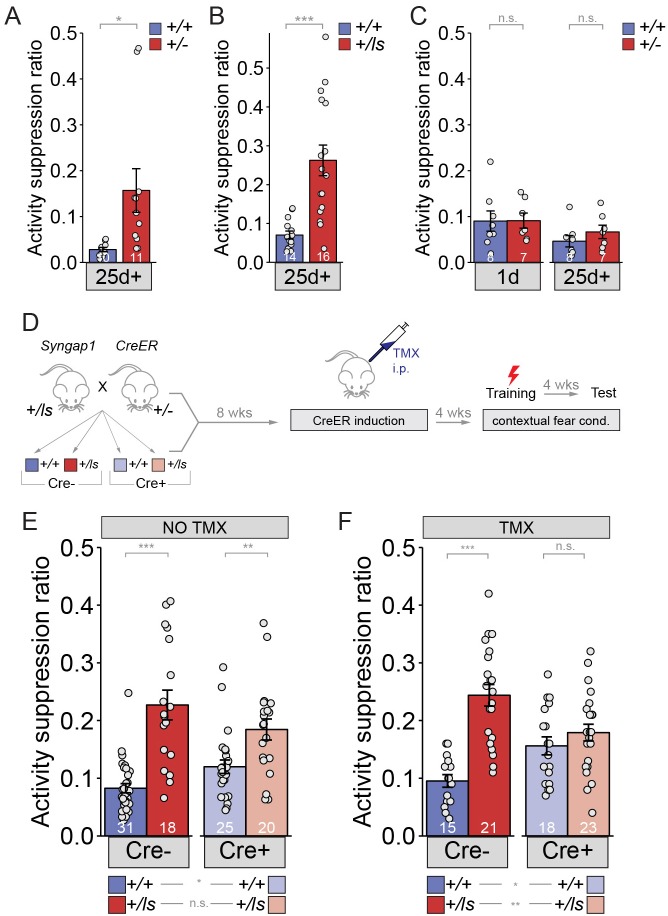
Long-term memory can be improved in adult mice with Syngap1 pathogenicity.(A) Syngap1+/+ and Syngap1+/- ± were trained in the remote contextual fear conditioning paradigm and tested one month later for activity suppression levels. Activity of the Syngap1+/- was suppressed significantly less than that of the Syngap1+/+ group indicating compromised remote memory for the mutant group. Unpaired t test (t(19)=-2.567, p=0.019). Cohen’s d = 1.150. (B) Syngap1+/+ and Syngap1+/ls mice were trained in the contextual fear conditioning paradigm and tested one month later for activity suppression levels. Activity of the Syngap1+/ls group was suppressed significantly less than that of the Syngap1+/+ group indicating compromised remote memory for the mutant group. Wilcoxon rank sum test W = 19, p=2.82E-5, Cohen’s d = 1.676. (C) Syngap1+/+ and Syngap1+/- were tested, firstly, 1d after training, followed by another testing one month later. Activity suppression levels were not significantly different between the groups for either testing (unpaired t test,1-day t(13)=-0.033, p=0.974; 26 days t(13)=-1.068, p=0.305). (D) Experimental schematic depicting the breeding strategy for generation of Cre-inducible Syngap1Cre+;+/ls mice and Cre induction with TMX treatment for restoration of Syngap1 expression and subsequent remote fear conditioning testing. (E–F) Syngap1Cre-;+/+, Syngap1Cre-;+/ls, Syngap1Cre+;+/+, and Syngap1Cre+;+/ls mice were run in the remote contextual fear conditioning paradigm without (E) and with (F) TMX administration. Activity suppression values from mice without TMX administration (No TMX) were assessed (2-factor ANOVA: Main Effects-Cre F(1,90)=0.030, p=0.864, Genotype F(1,91)=46.78, p=9.28E-10, Interaction F(1,91)=6.81, p=0.011; Cre- Cohen’s d = 1.725, Cre+ Cohen’s d = 0.910. With TMX administration (2-factor ANOVA: Main Effects- Cre F=(1,73)=0.019, p=0.891, Genotype F(1,73)=27.49, p=1.48E-6, Interaction F(1,73)=14.75, p=2.59E-4; Cre- Cohen’s d = 2.167). Data points (and numbers) in bars represent biological replicates (animals). Data from panels E-F are pooled from at least two separate experiments.10.7554/eLife.46752.013Figure 4—source data 1.Source data for Figure 4A.10.7554/eLife.46752.014Figure 4—source data 2.Source data for Figure 4B.10.7554/eLife.46752.015Figure 4—source data 3.Source data for Figure 4C.10.7554/eLife.46752.016Figure 4—source data 4.Source data for Figure 4E.10.7554/eLife.46752.017Figure 4—source data 5.Source data for Figure 4F.